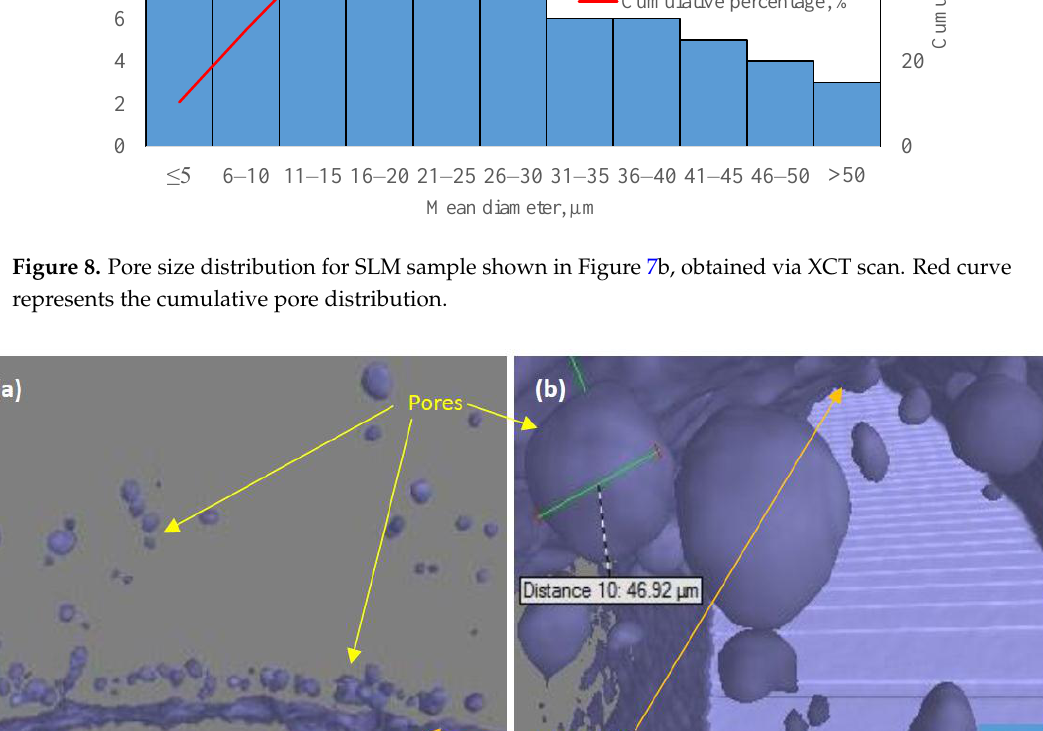
Figure 8. Pore size distribution for SLM sample shown in Figure 7b, obtained via XCT scan. Red curve represents the cumulative pore distribution.